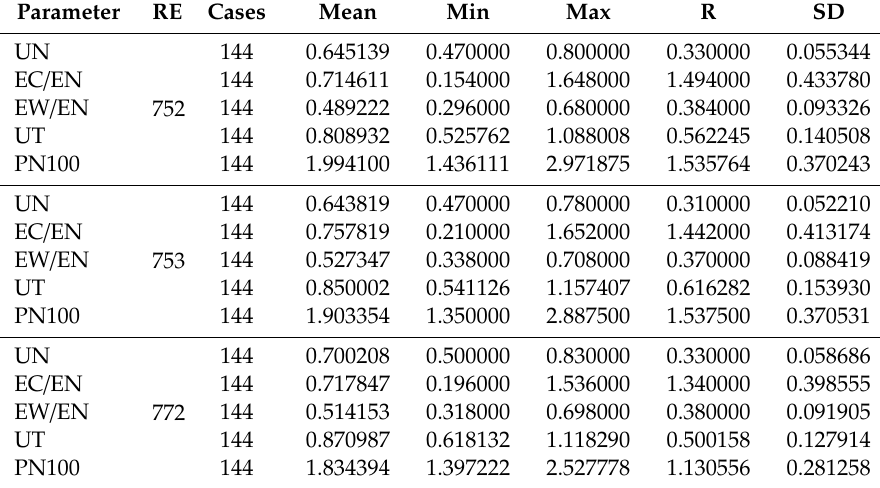
Table 4. Variation of lighting parameters for each set of reflectances